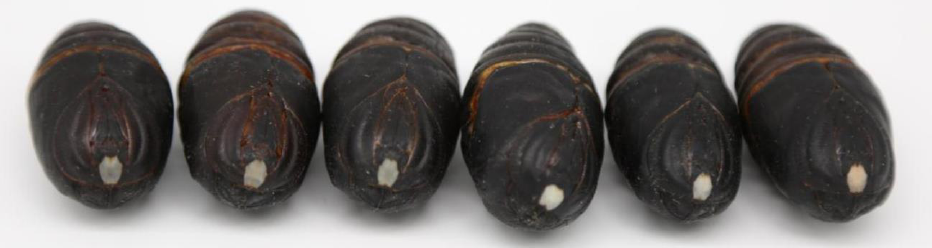
Figure 1. Changes in the window above the pupal brain during diapause and eclosion. From diapause to eclosion, the window changes from transparent to milky white, and finally to red.